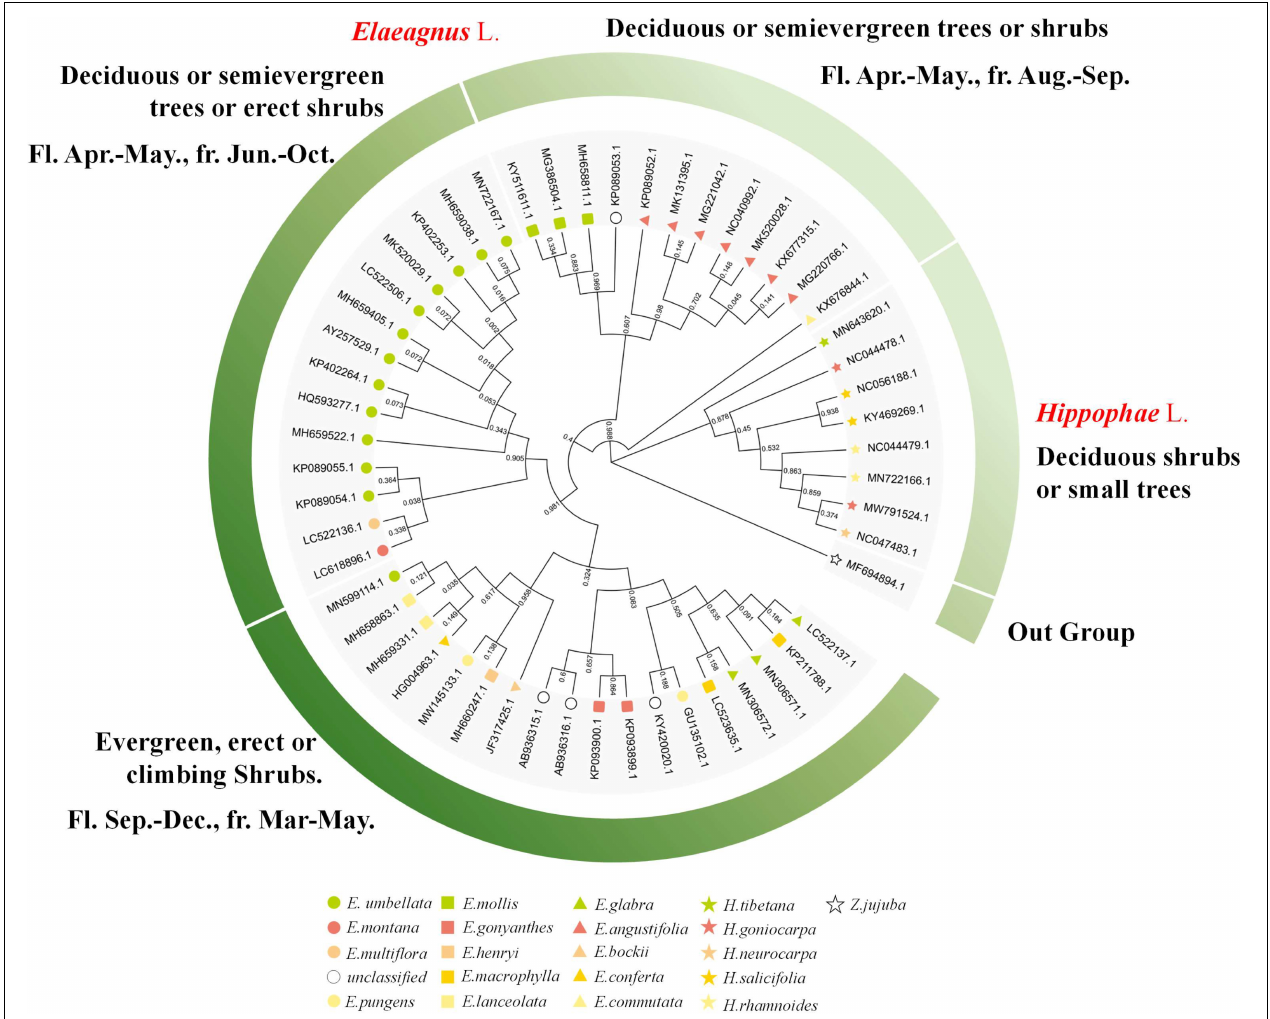
FIGURE 1 | Phylogenetic tree combined with the main plant taxonomic features constructed with the matK sequences for Elaeagnus plants (Bootstrap values are expressed as decimals).